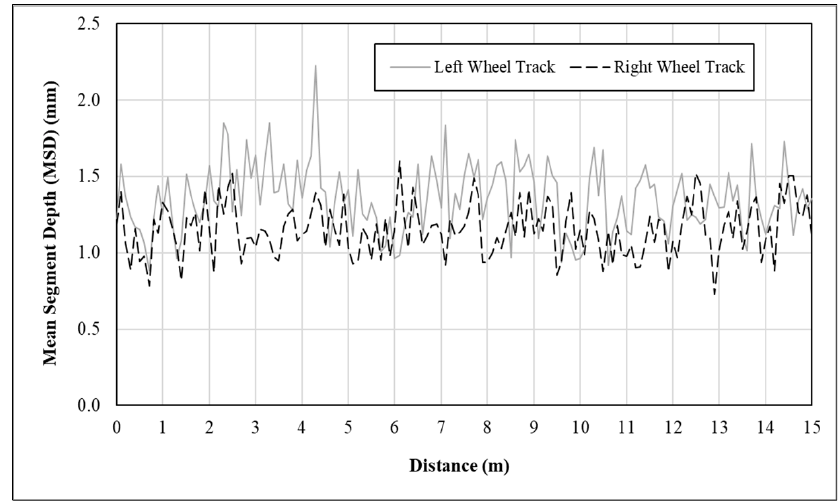
Figure 2. Graphical illustration of mean segment depth (MSD) measurements.